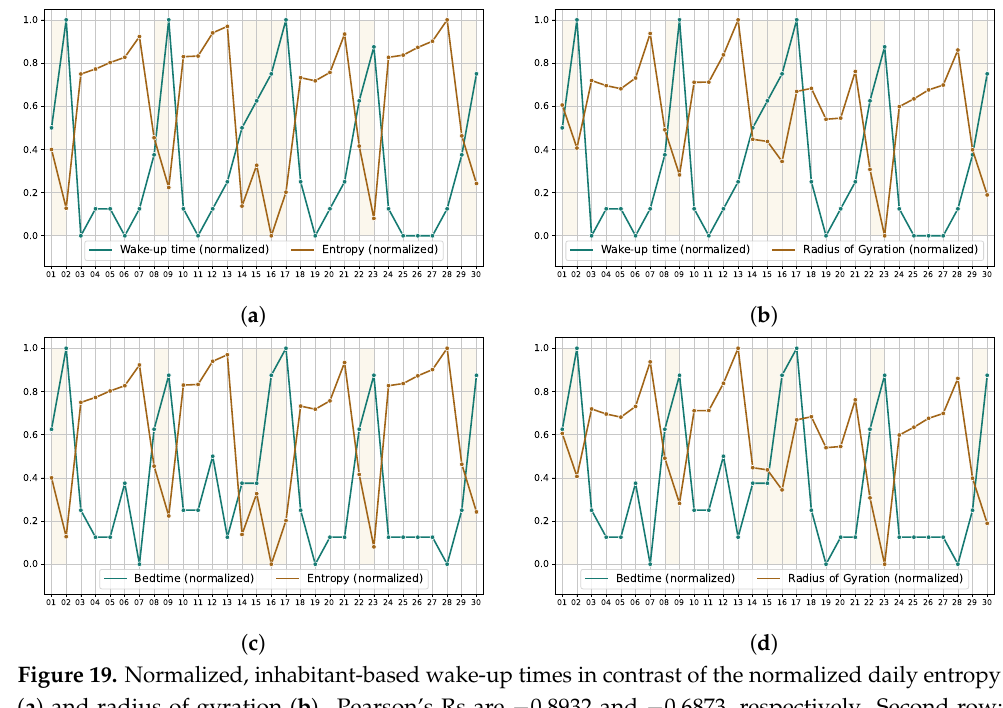
Figure 19. Normalized, inhabitant-based wake-up times in contrast of the normalized daily entropy ( a ) and radius of gyration ( b ). Pearson’s Rs are − 0.8932 and − 0.6873, respectively. Second row: Normalized, inhabitant-based bedtimes in contrast of the normalized daily entropy ( c ) and radius of gyration ( d ). Pearson’s Rs are − 0.85 and − 0.6621,